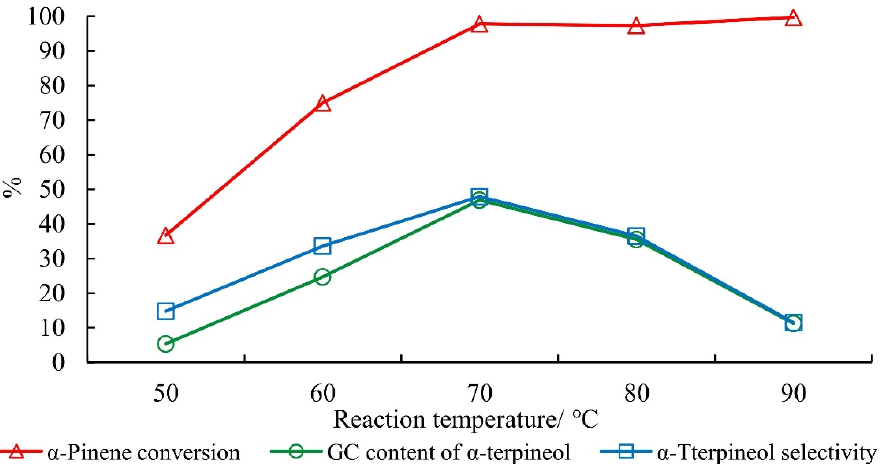
Figure 9. Effect of reaction temperature on the hydration of alpha-pinene. Note: Mass ratio of alpha-pinene, water, acetic acid, citric acid, and phosphoric acid was 1:1:2.5:0.1:0.05 for 15 h.